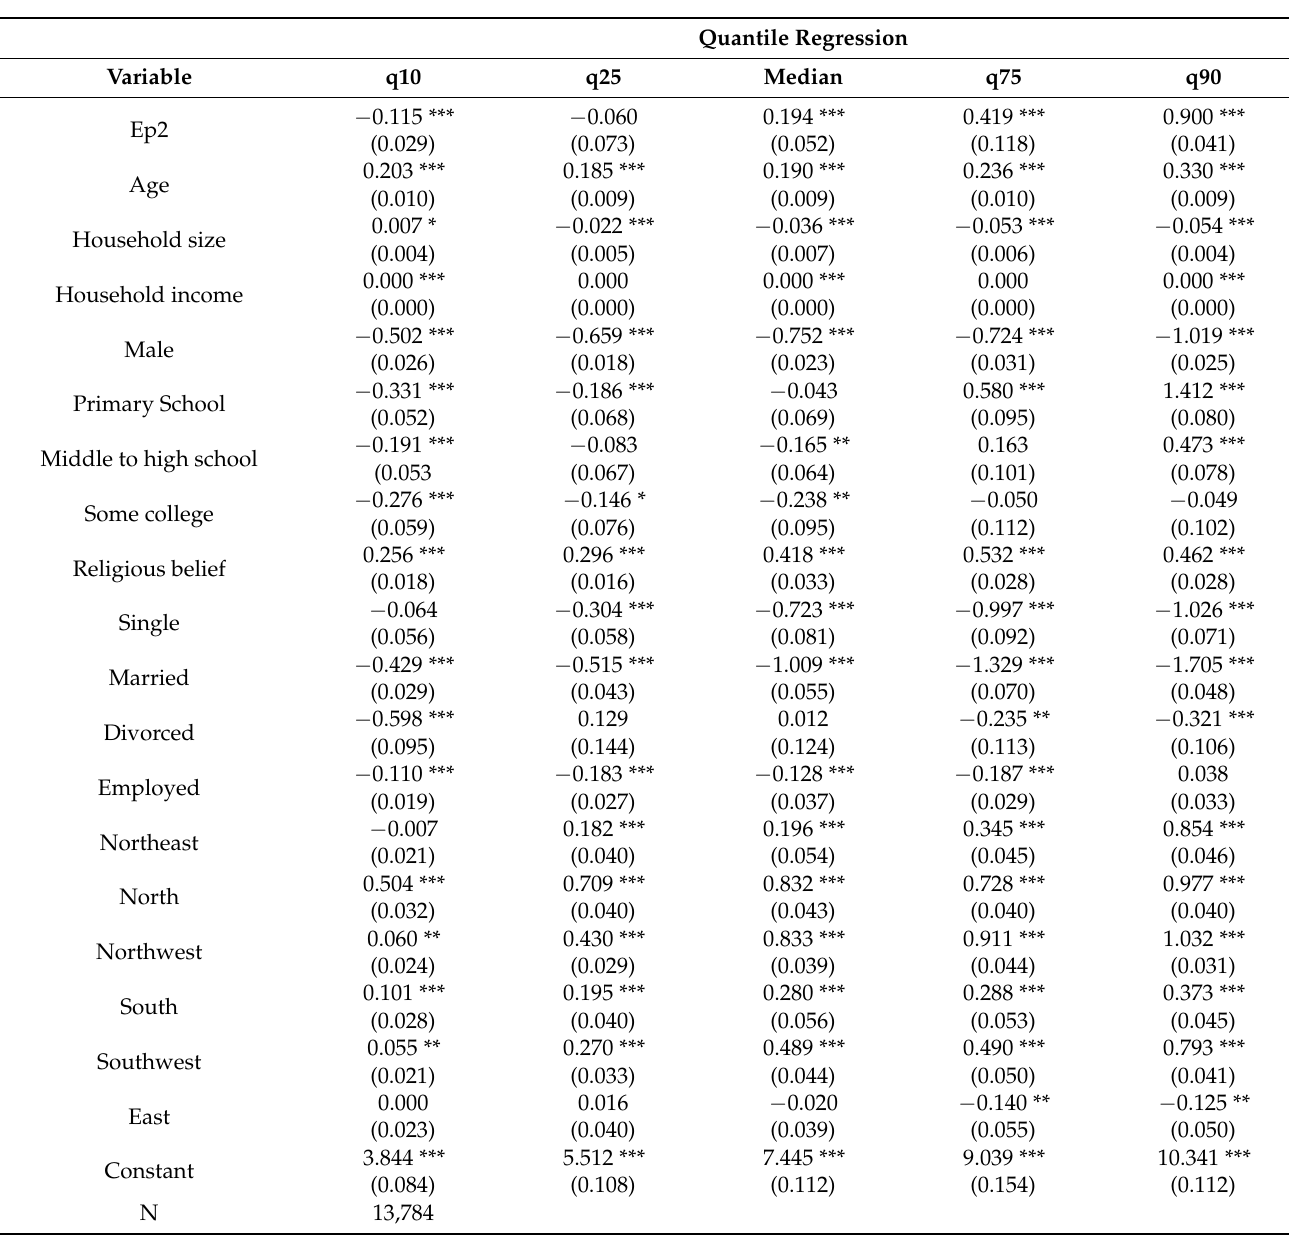
Table A3. Estimated parameter coefficients from the instrumental variable quantile regression model with EP2 as energy poverty